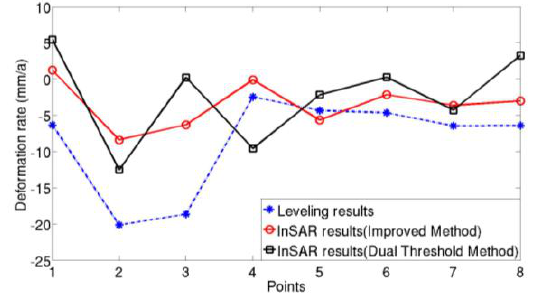
Figure 12. Comparison between PSInSAR results and leveling